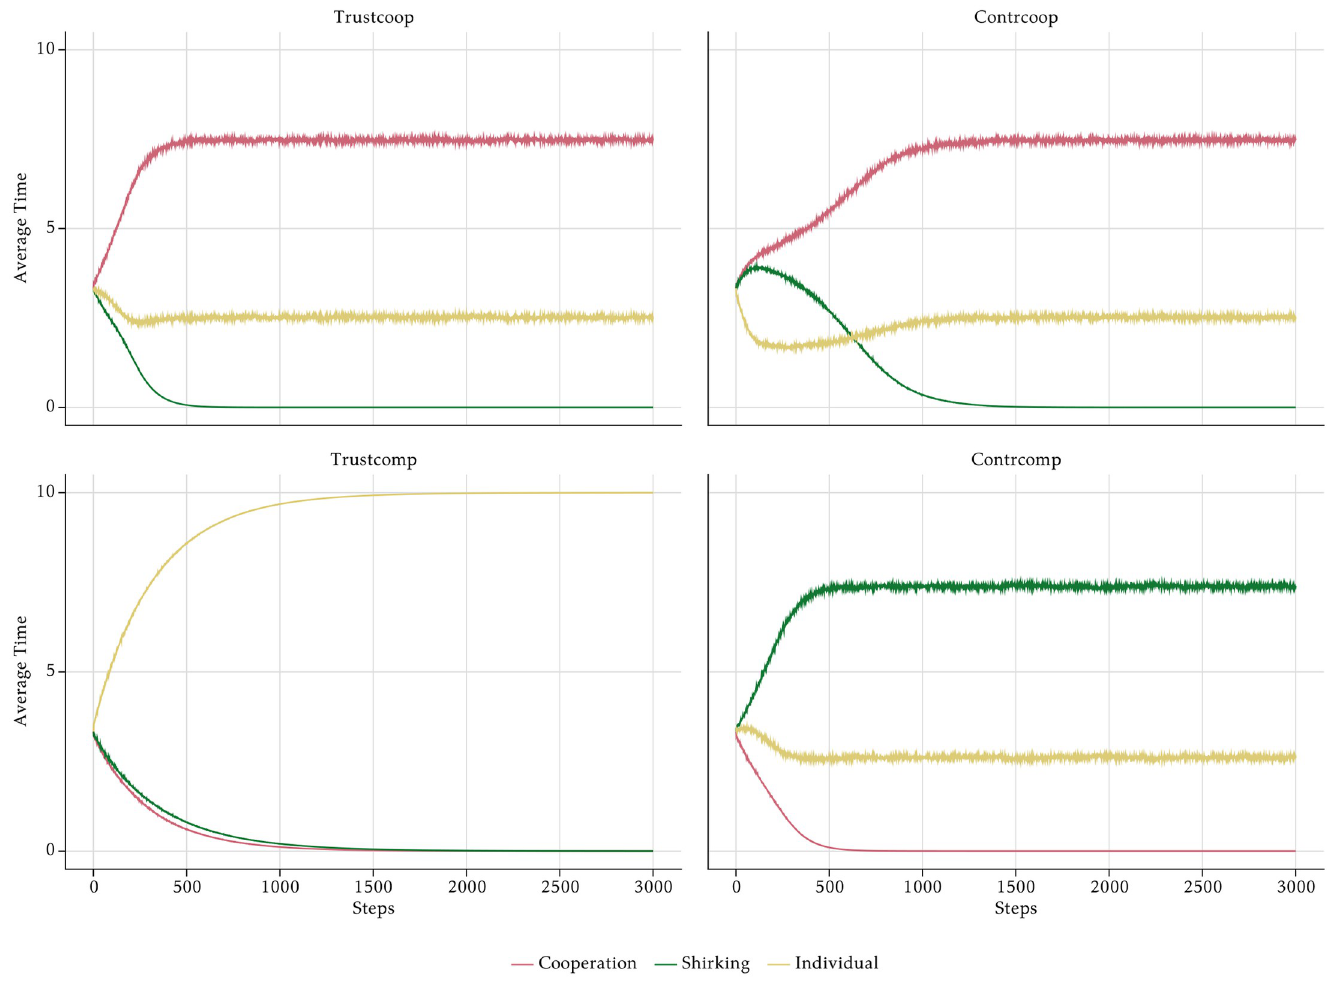
Fig 16. Aggregate average time—PFP schemes and monitoring strategies.